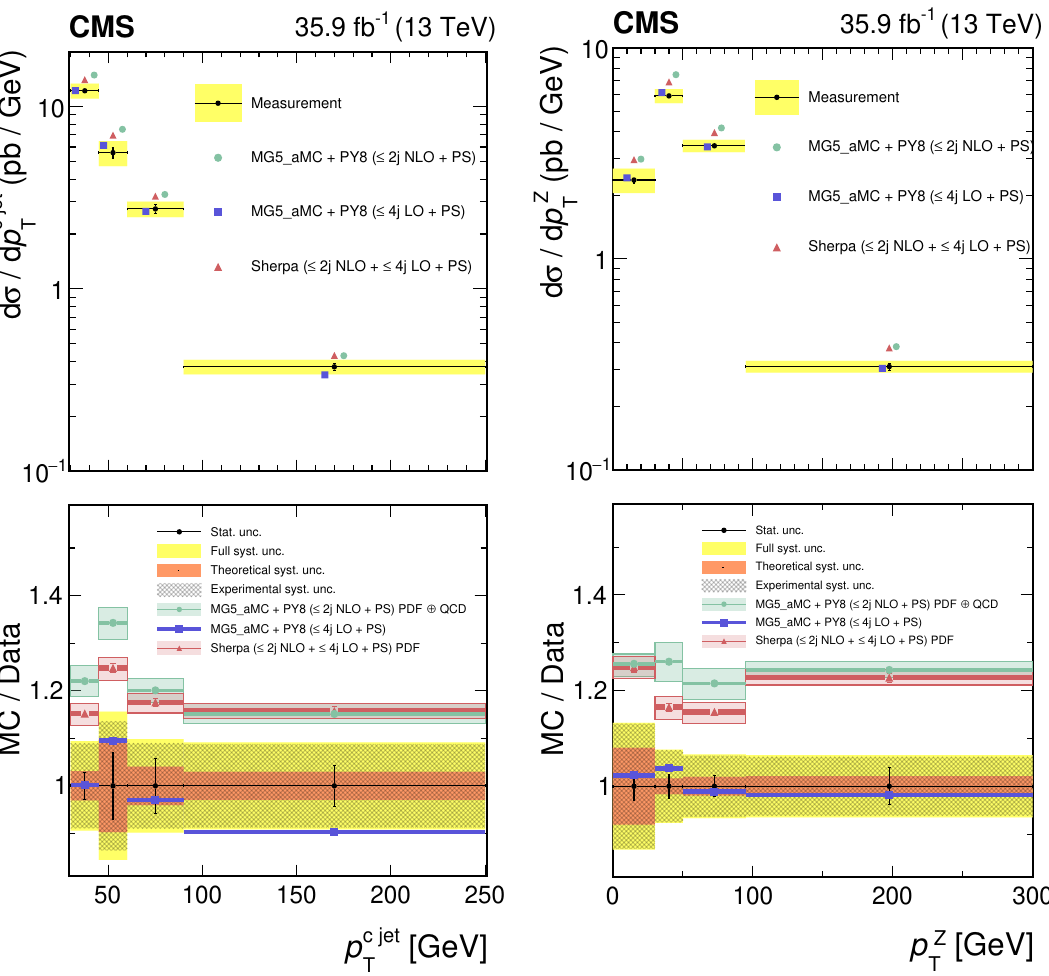
Figure 7 . Measured fiducial differential cross sections for inclusive Z + c jet production, d σ/ d p c jet (left) and d σ/ d p Z (right). Yellow band shows total systematic uncertainties. Predictions from T MG5_aMC (LO) are shown with statistical uncertainties only. The vertical bars on the data points represent statistical uncertainties.